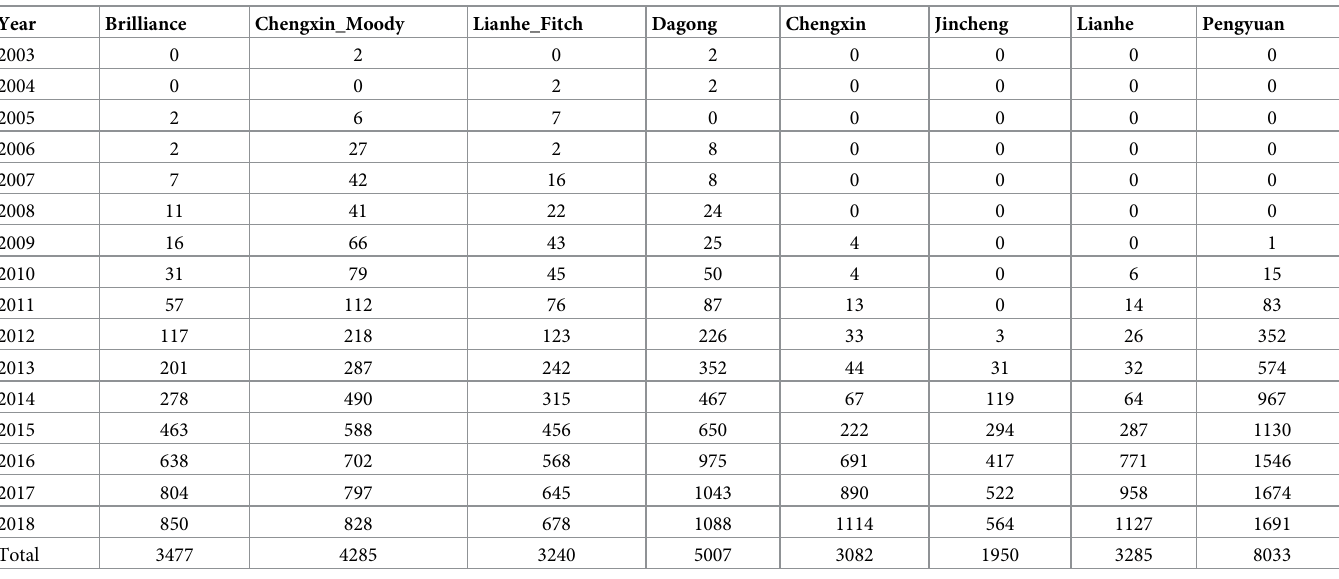
Table 6. Market shares of different rating